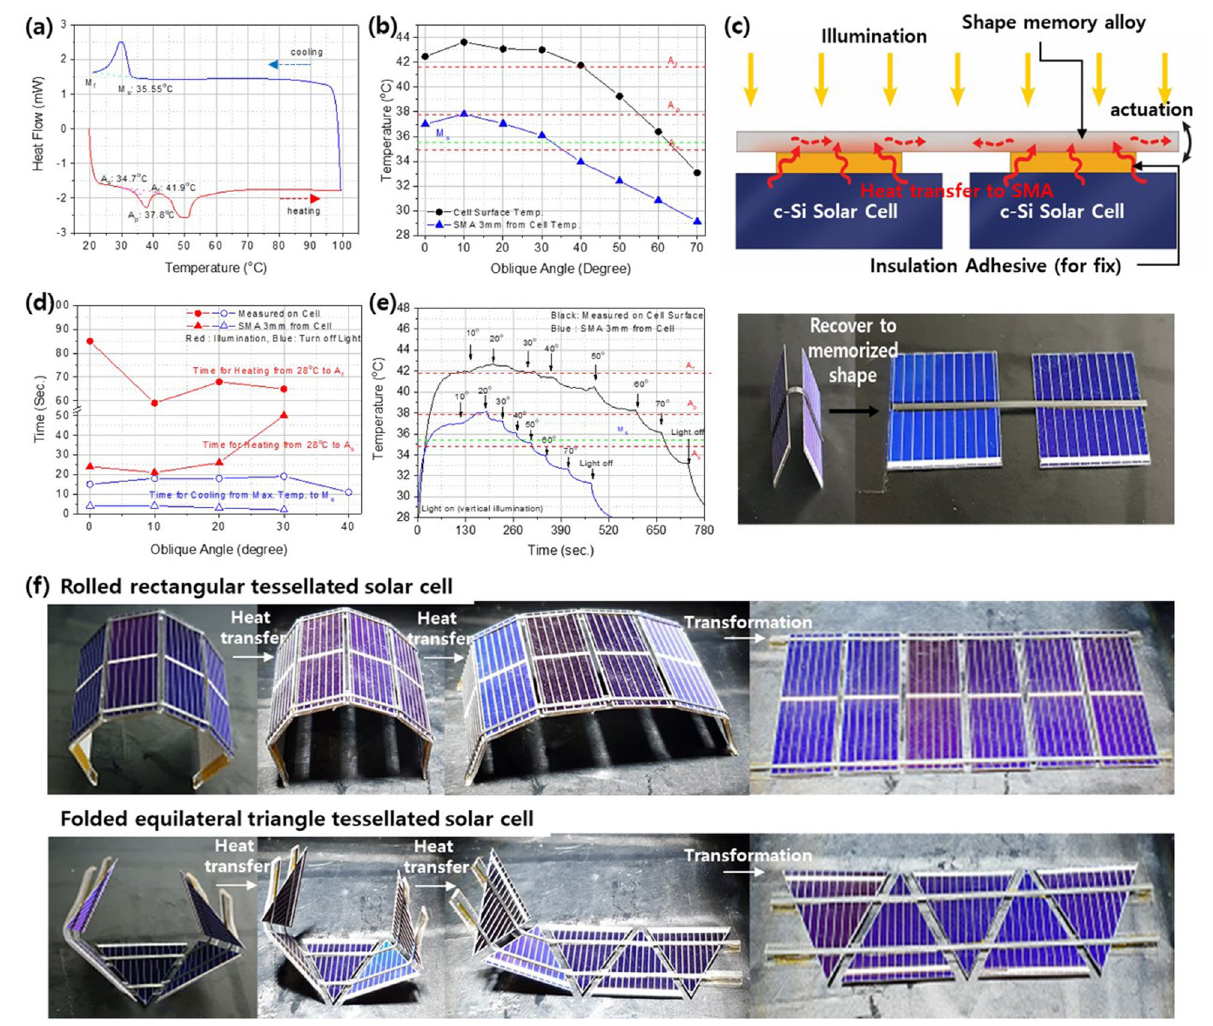
Figure 2. ( a ) Differential scanning calorimetry (DSC) analysis of shape memory and ( b ) the temperatures of the surface of the solar cell and the shape-memory alloy attached to the solar cell. ( c ) Schematic illustration of the heat-transfer process and shape-memory actuation. ( d , e ) Heating and cooling times of the surface of the solar cell and of the shape-memory alloy depending on the angle of incidence (AOI) under illuminated and non-illuminated conditions. ( f ) Photographs of the transformation process of rectangular and equilateral- triangle tessellated solar cells from folded to flattened